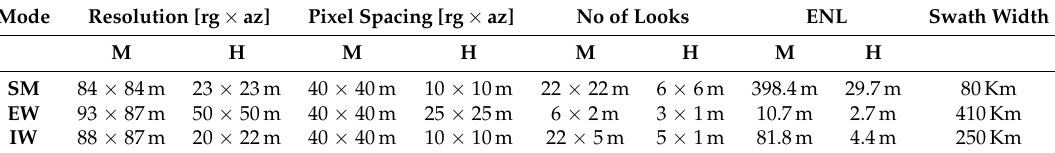
Table 1. Summary of the characteristics of the main Ground Range Detected (GRD) products.